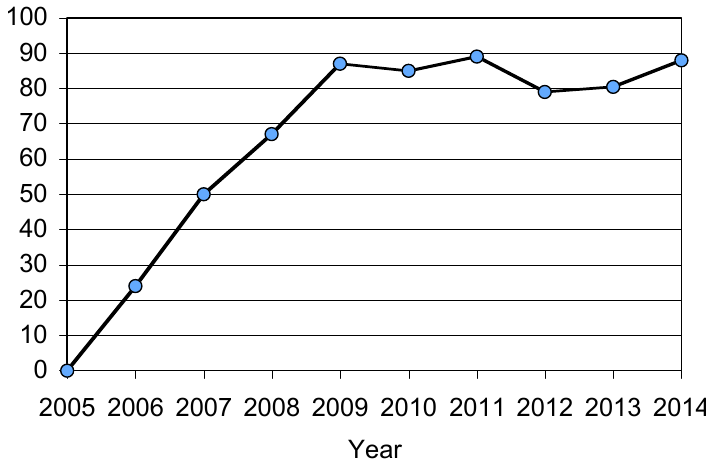
Figure 9. The development of cattail cover in STA1E Cell 5 (231 ha). Flow-through began in October 2005. The site was a citrus grove prior to wetland construction.